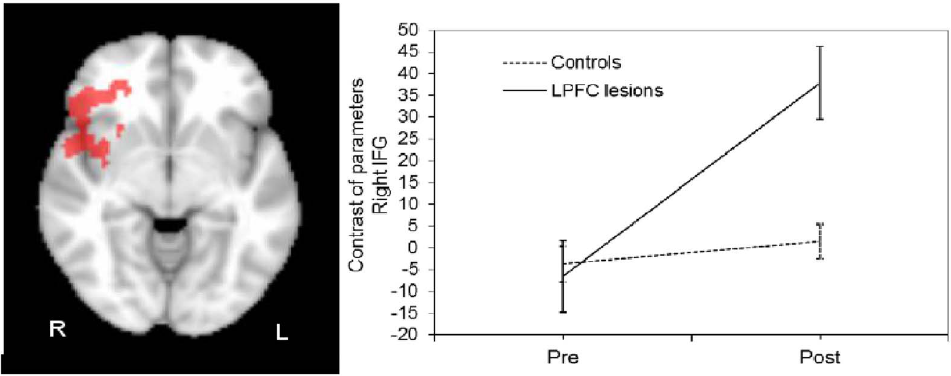
Figure 4. Axial slice showing the cluster with local maxima in right IFG (MNI coordinates 48, 28, 2 6). Group x fMRI Session interaction was significant (voxel Z . 2.3, cluster corrected p , 0.001) for the contrast RNS . baseline. The graph shows the amplitude of BOLD responses in right inferior frontal gyrus (mean and standard error). Functional MRI session-related differences in the contrast of parameters estimate values are greater for LFL patients compared to